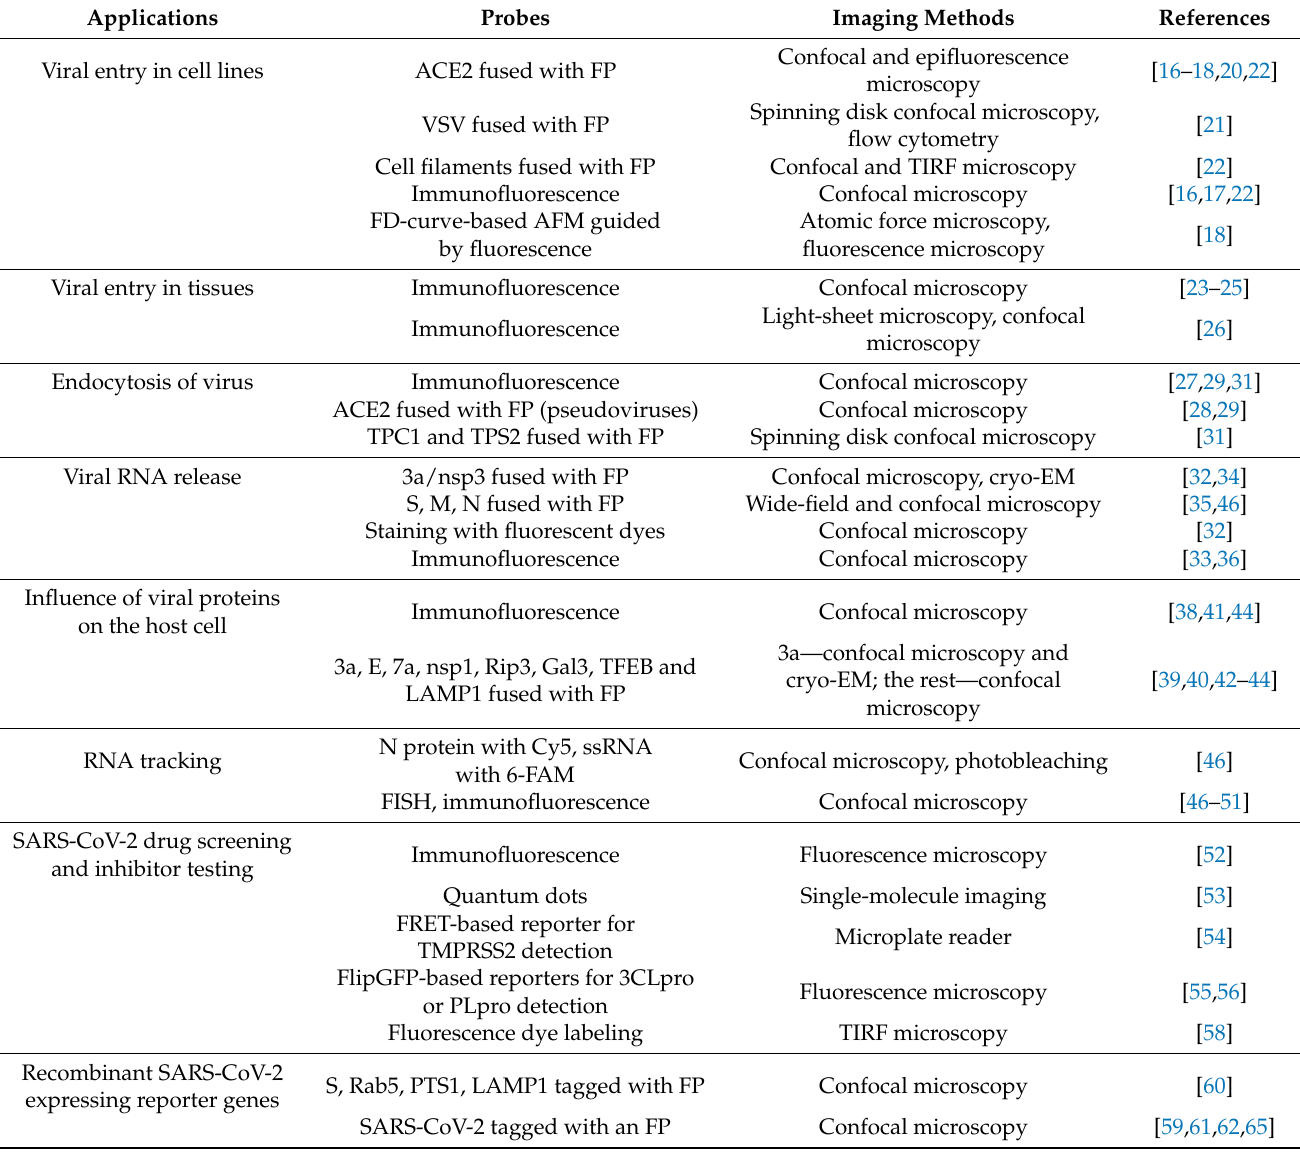
Table 1. Summary of fluorescent probes and imaging methods used to study